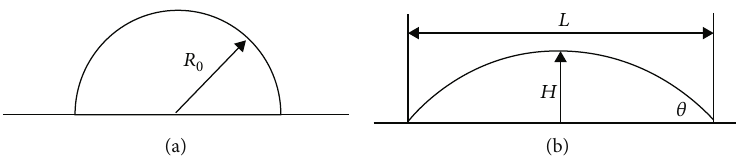
Figure 5: Illustration of initial and spread droplet shapes: (a) initial droplet shape and (b) spread droplet shape. Table 2: Physical parameters of droplet spreading in cases.